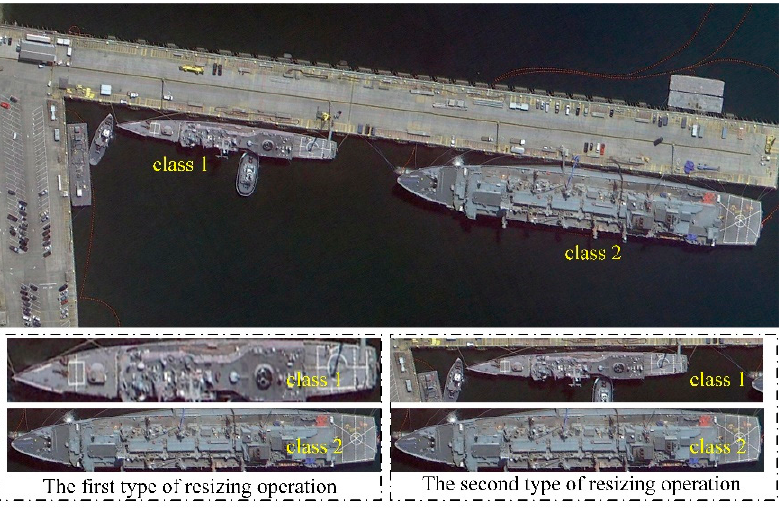
Figure 1. Examples of two types of image normalization methods.